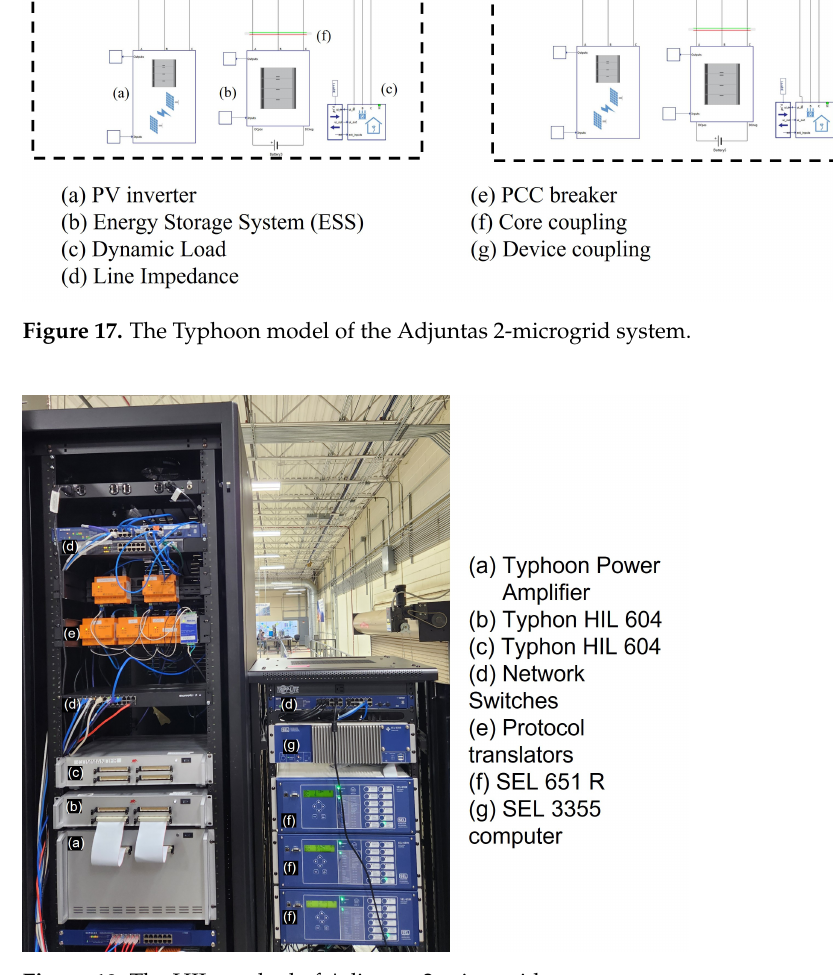
Figure 18. The HIL test bed of Adjuntas 2-microgrid